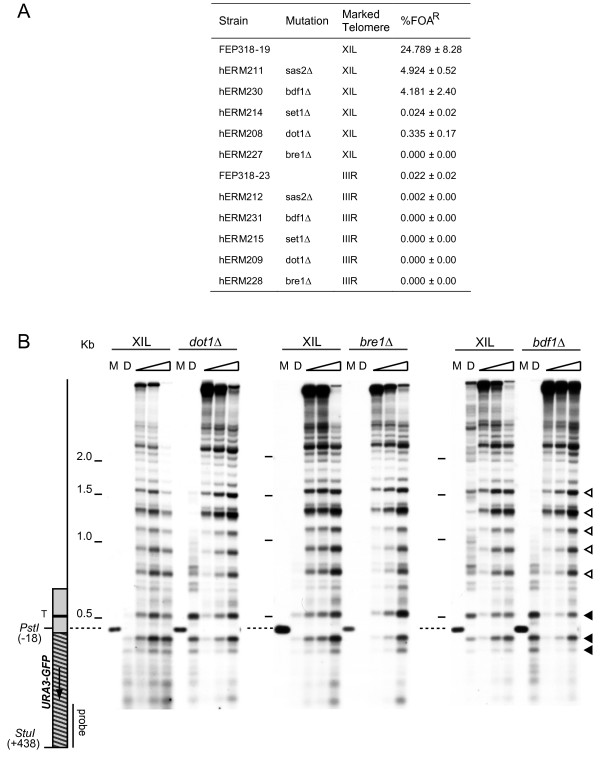
Histone modifiers are required for silencing but not nucleosome positioning at telomeres. (A) Frequency of fluoroorotic acid (FOA) resistance in isogenic Δbre1::KanMX, Δdot1::KanMX, Δset1::KanMX, Δsas2::KanMX, and Δbdf1::KanMX strains containing the URA3-yEGFP marker adjacent to the core X element at the indicated telomere. The mean and standard deviation of FOA resistance is given for each strain. (B) The subtelomeric chromatin structure of the XIL telomere was analysed in the Δbre1::KanMX, Δdot1::KanMX, and Δbdf1::KanMX strains, by MNase digestion and indirect end labelling, as for Figure 1B.